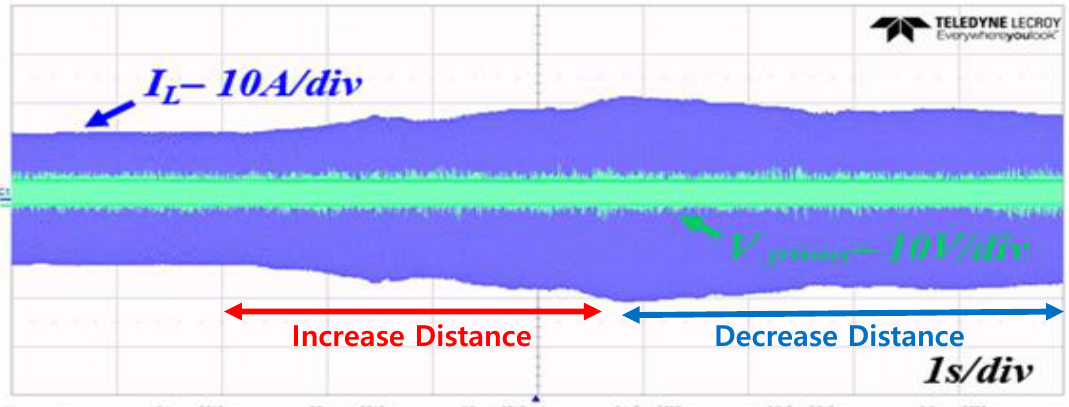
Figure 17. Wave of primary voltage and current following the distance.